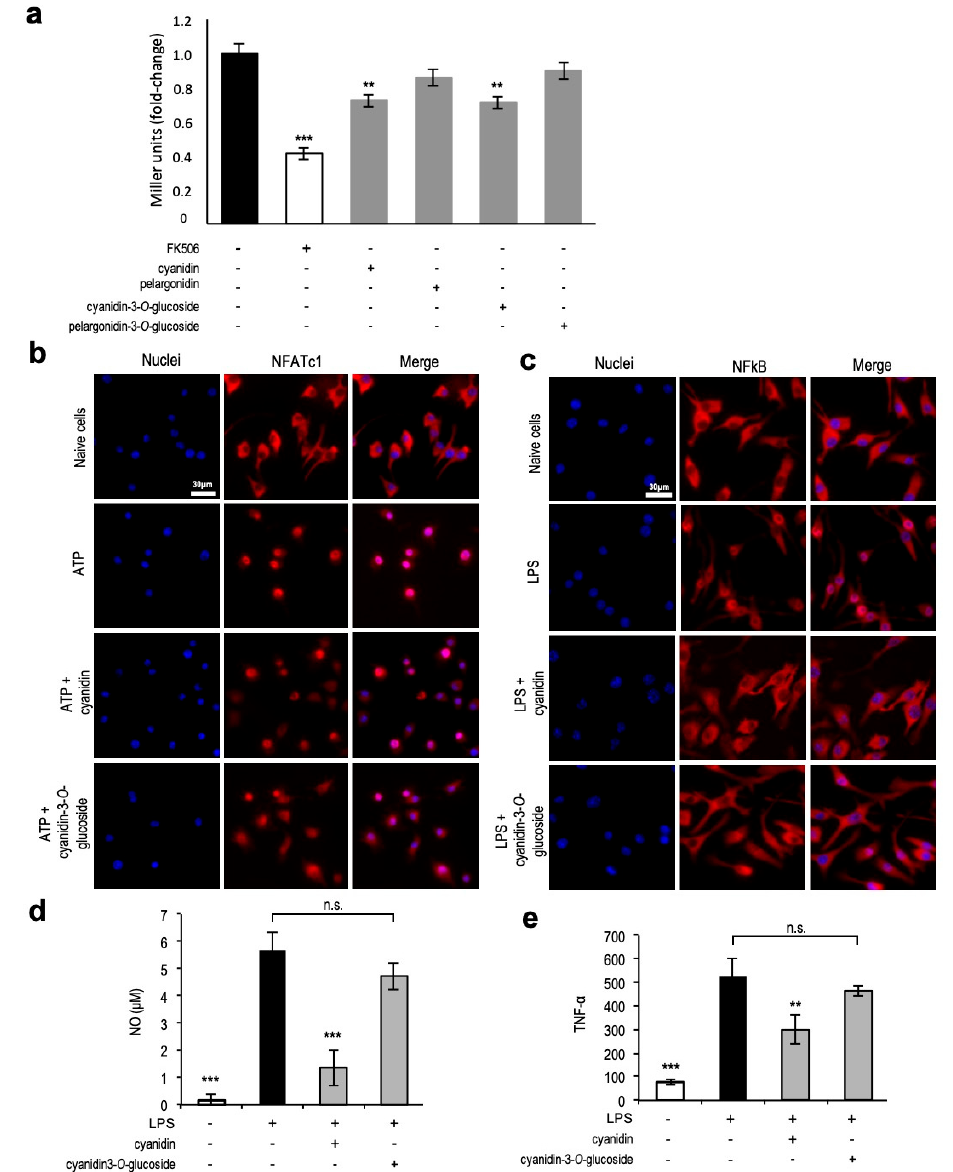
Figure 5. Cyanidin modulates Crz1 activation in yeast and NFAT and NF-kB in microglia. ( a ) BY4741 yeast strain encoding CRZ1 promoter –lacZ was subjected or not to 50 µ M of the indicated compounds, induced with 1.8 mM MnCl 2 , and Crz1 activation was assessed by monitoring β -galactosidase activity using 2-Nitrophenyl β - d -galactopyranoside (ONPG). The immunosuppressant FK506 was used as a positive control. ( b ) NFATc1 and ( c ) NF-kB translocation to the nucleus in N9 cells pre-treated with 5 µ M cyanidin or cyanidin-3- O -glucoside for 6 h before 1 h ATP stimulation (NFATc1) or LPS stimulation (NF-kB). NFATc1 and NF-kB were immunostained with Alexa Fluor 594 (red) and nuclei were stained with DAPI (blue). ( d ) NO and TNF- α release in N9 cells pre-treated with 5 µ M cyanidin or cyanidin-3- O -glucoside for 6 h before LPS stimulation (NF-kB). Representative images are shown, and the values represent the mean ± SEM of at least three biological replicates, ** p < 0.01, *** p < 0.001.